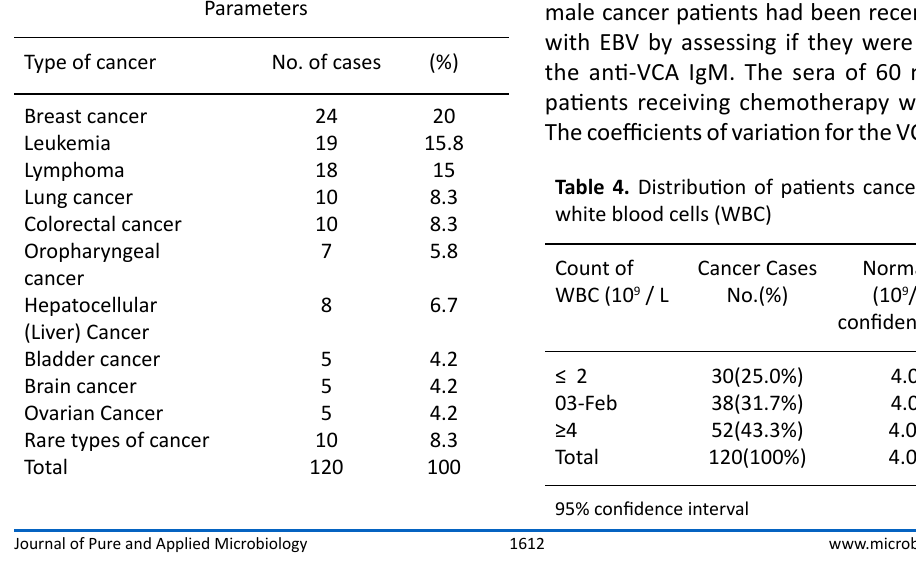
Table 3. Distribution of patients with types of cancer(n=120) from male and female Parameters